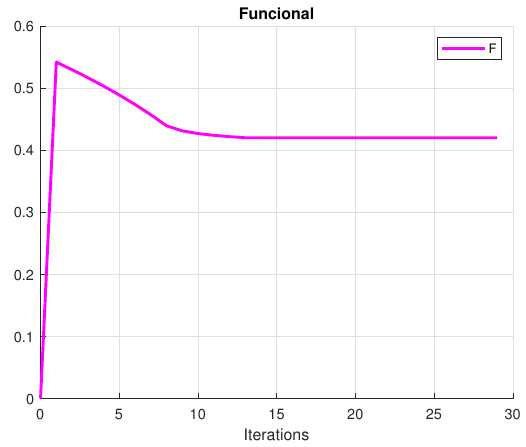
Figure 2. Variance value of the portfolio.